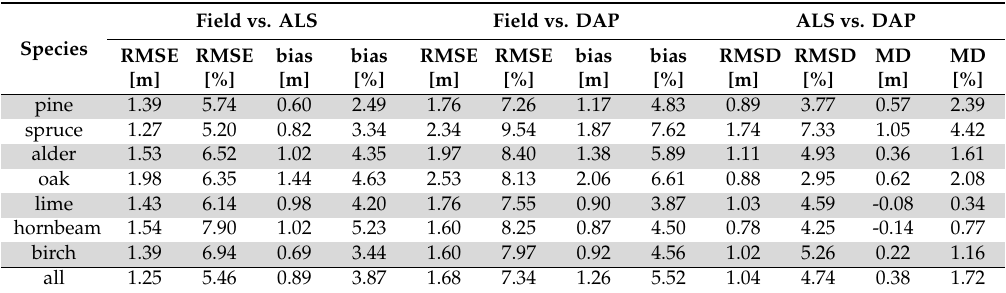
Table 5. Errors (RMSE and bias) and di ff erences (RMSD and MD) obtained for the applied methods of height estimation (divided by